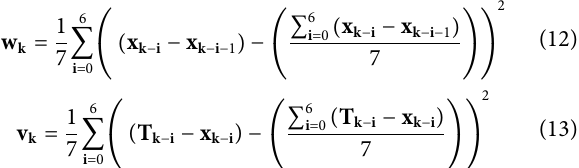
Frontiers in Energy Research |